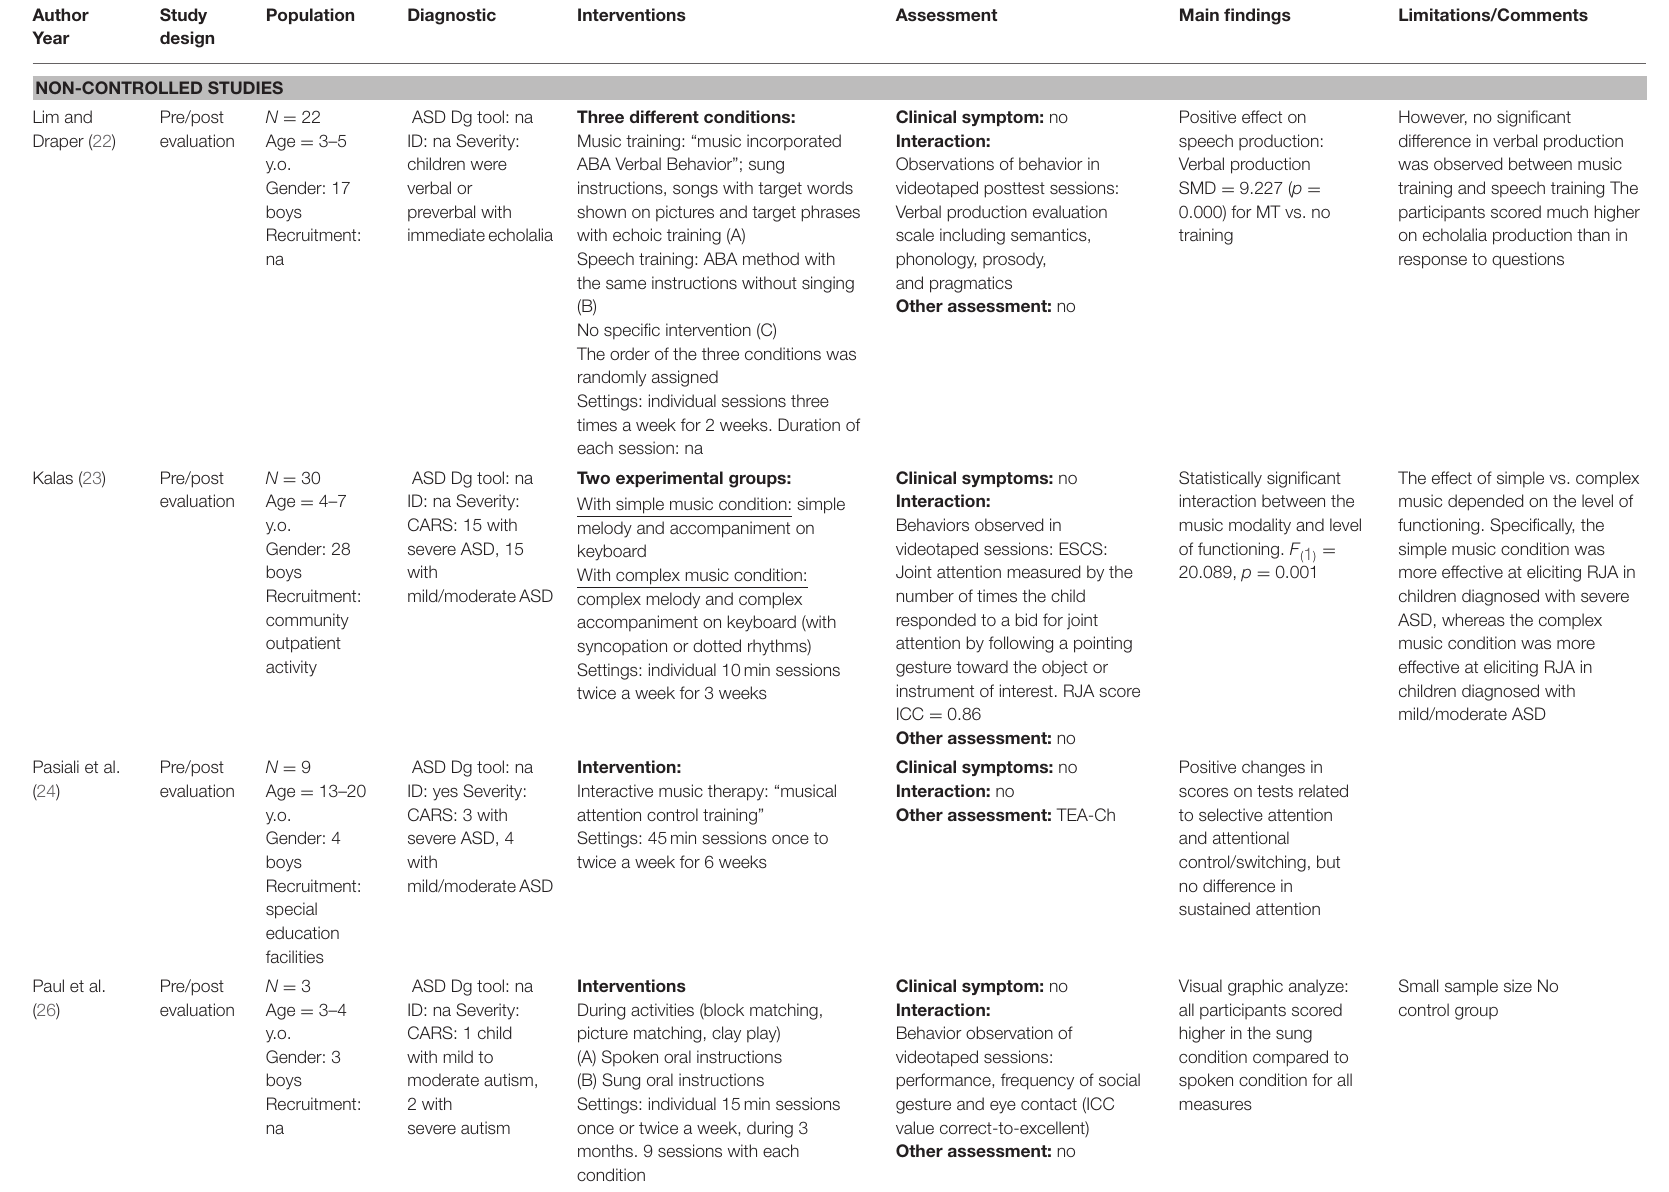
TABLE 1 | Studies assessing educational musicotherapy in patients with autism spectrum disorder